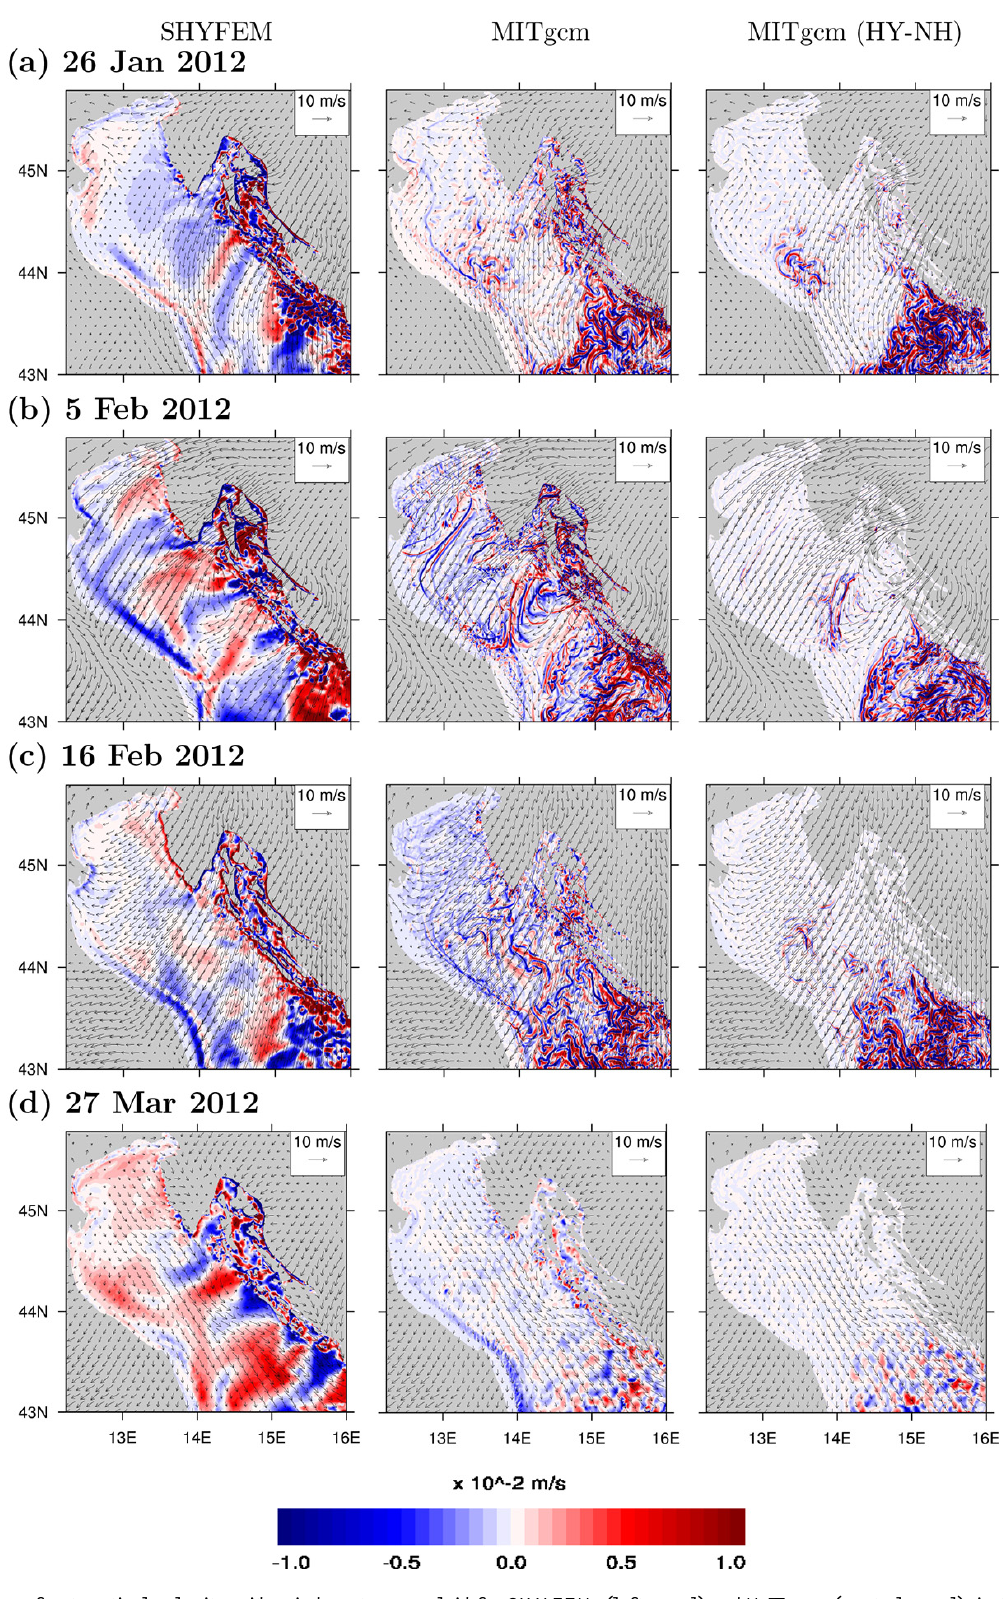
Figure 9. Maps of net vertical velocity with wind vectors overlaid for SHYFEM (left panel) and MITgcm (central panel), in the hydrostatic implementation, and differences in net vertical velocity between MITgcm hydrostatic and nonhydrostatic implementations (HY-NH, right panel), for the dates indicated. Red and blue colors in the net vertical velocity maps indicate upward and downward